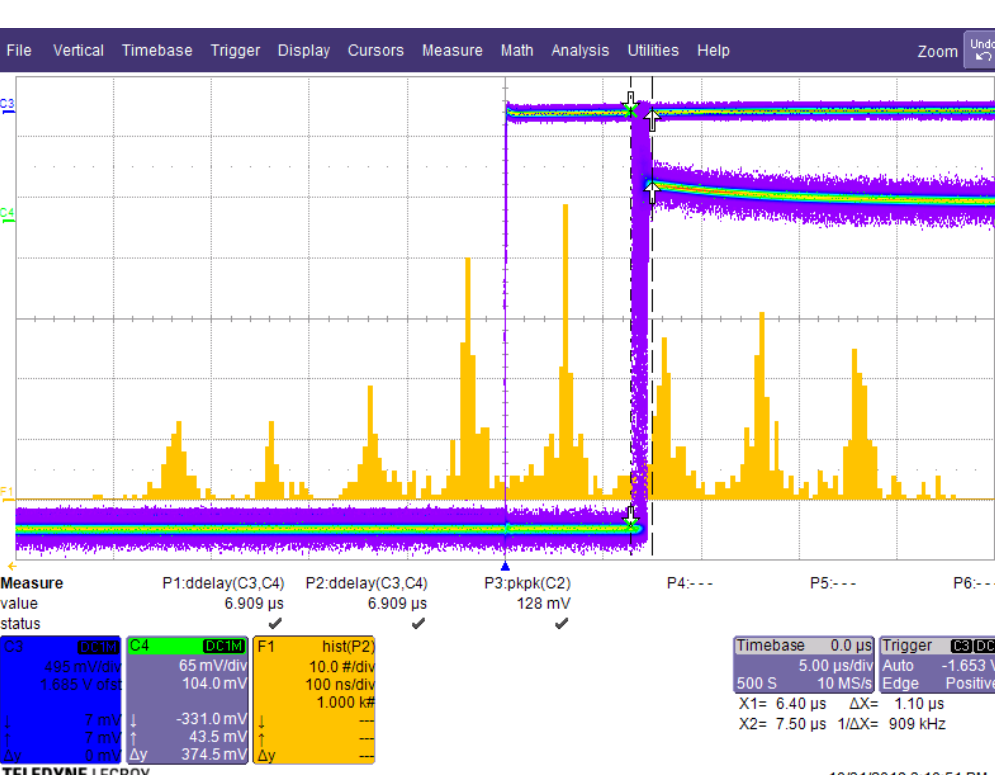
Figure 7. Protocol